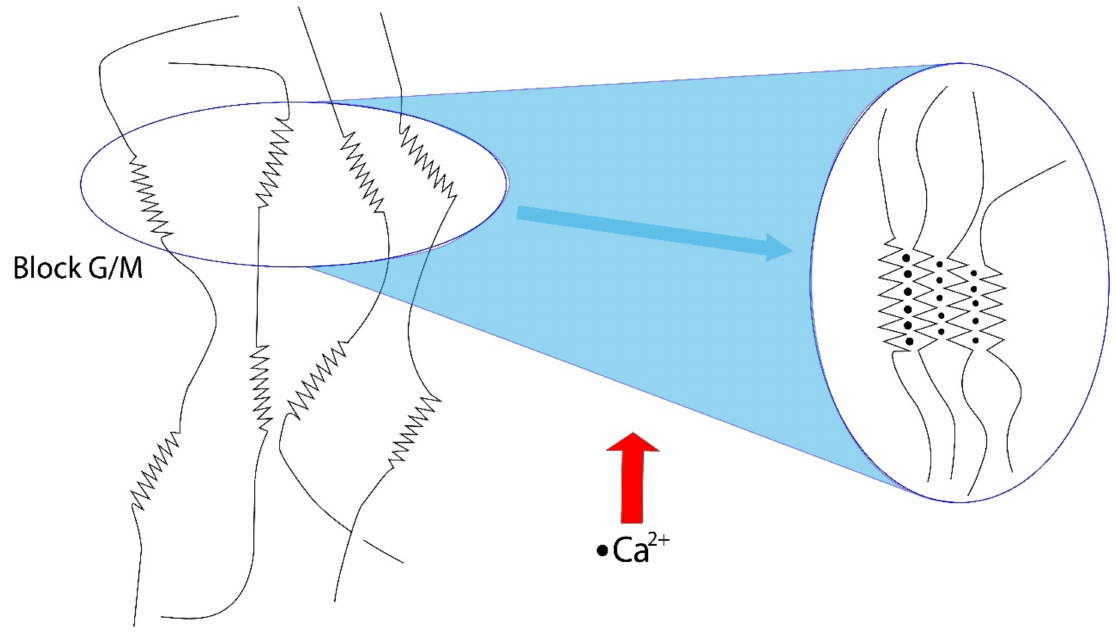
Figure 2. Alginate egg box fix in the presence of Ca 2+